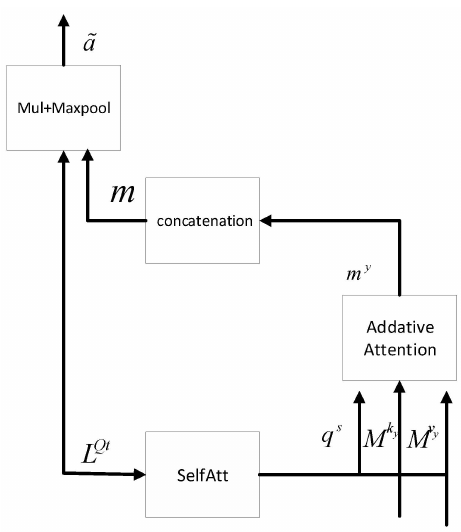
Figure 3. The question in light of the knowledge base (KB). Mul: Vector